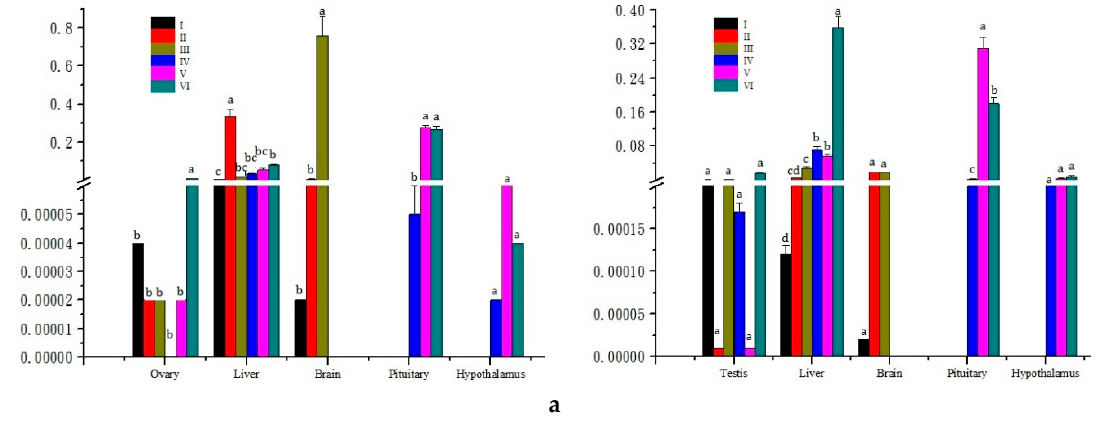
a Figure 4. Cont. Figure 4. Cont. Figure 4.